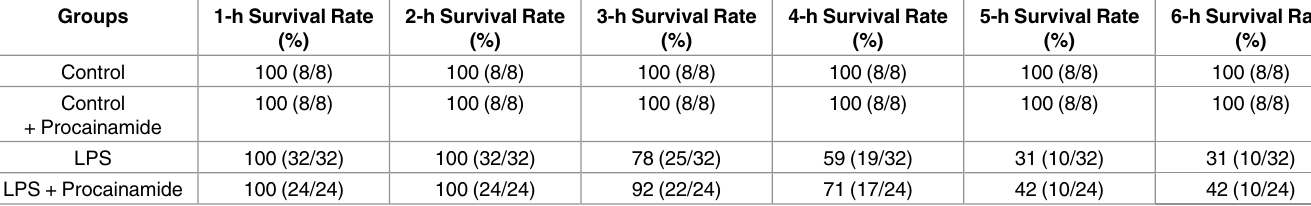
Depiction of the changes in survival rate during the experimental period in different groups of animals. Control, rats were given saline at time 0 (n = 8); Control + Procainamide, rats were given saline as in Control group and then given procainamide at 1 h (n = 8); LPS, rats were given LPS at time 0 (n = 32); LPS + Procainamide, rats were given LPS at time 0 and then given procainamide at 1 h (n = 24). Data are expressed as percentage of rats survived at the observed time